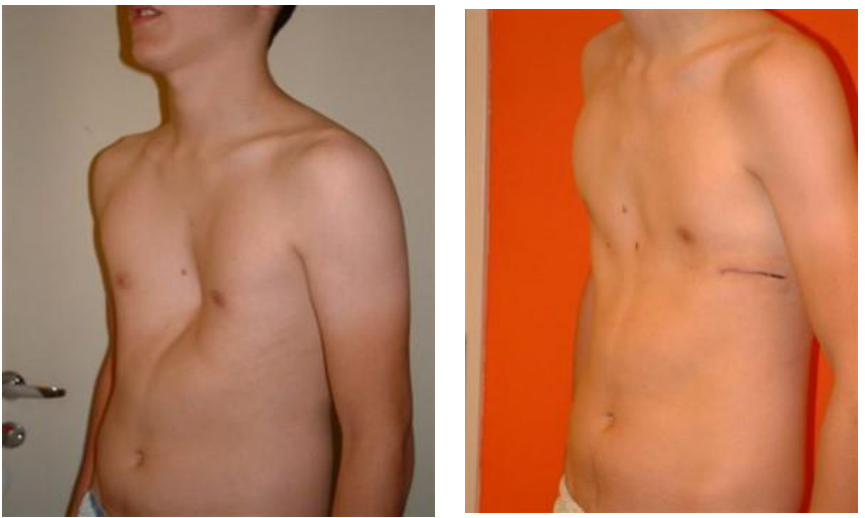
Figure 2. A boy with a pectus excavatum deformity before the surgery and after the standard Nuss procedure.